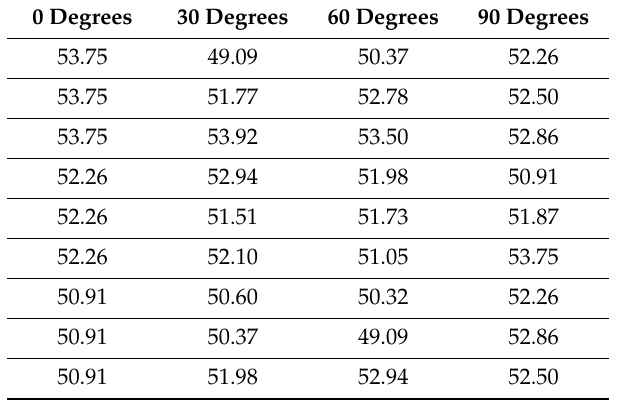
Table 14. DOE setup for UTS as a function of angular orientations.